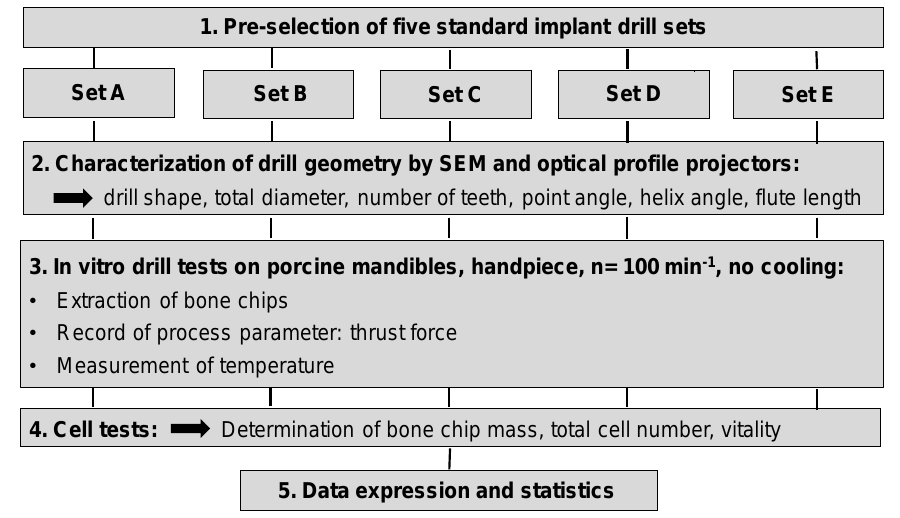
Figure 1. Schematic diagram of the study design.